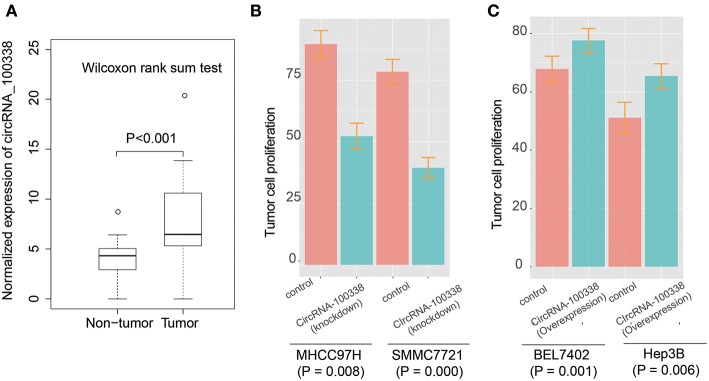
The expression patterns of circRNA-100338 and RHEB, and their expression correlation in HCC. (A) The expression levels of circRNA-100338 in non-tumor and tumor tissues. The differential expression levels are evaluated by Wilcoxon rank-sum test. (B,C) The tumor cell proliferation assays for HCC cell lines, including MHCC97H, SMMC7721, BEL7402, and Hep3B, with presence or absence of circRNA-100338.